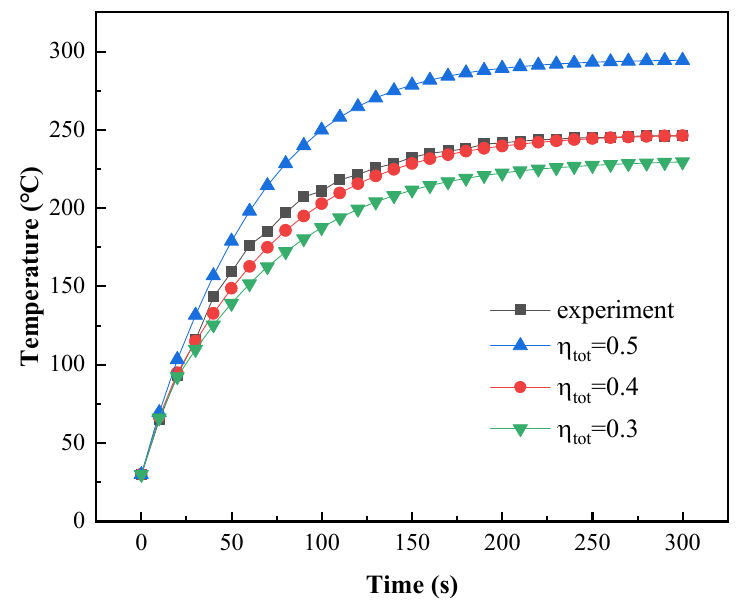
Figure 19. Comparison of measured and simulated coating temperatures. Table 8. Relative errors for measured and simulated coating temperatures ( η tot = 0.4).